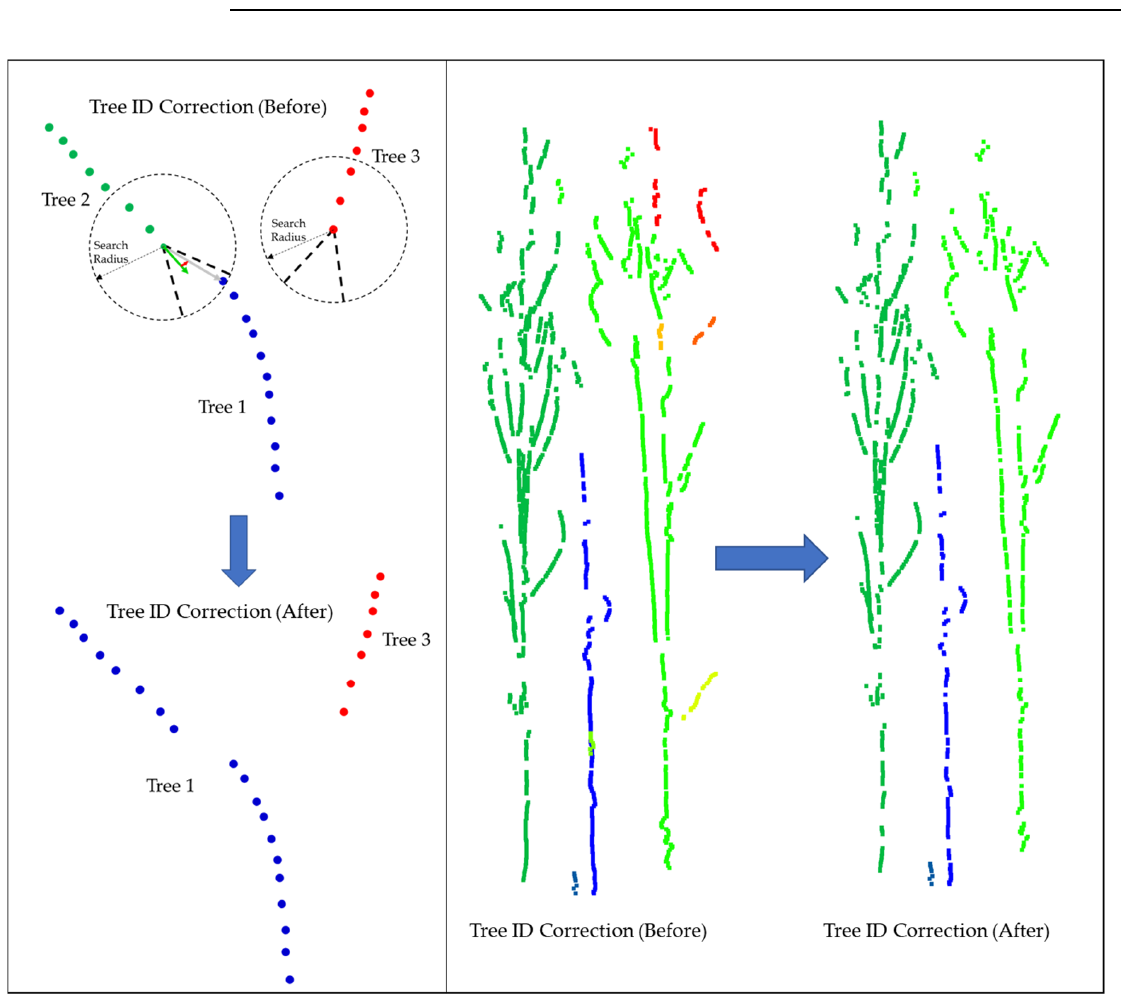
Figure 7. The second step of the cylinder sorting algorithm. All points shown are a point-based representation of a cylinder with X, Y, Z coordinates, a major axis vector (Vx, Vy, Vz), radius, circumferential completeness index, and Tree ID. Left: A simple example showing how three tree groups become two trees, as the lowest point of Tree 2 finds one of the points in Tree 1 meets the matching criteria. Tree 2 is joined to Tree 1 as a result. Tree 3 does not find any other groups nearby. If the lowest point of Tree 3 is below 5 m above the ground, it will be kept, and if not, it will be deleted. Right: A real example on the same trees shown in Figures 3–5. The small orange, red and yellow groups of points were deleted, as they did not meet the matching criteria and were greater than 5 m above the ground.